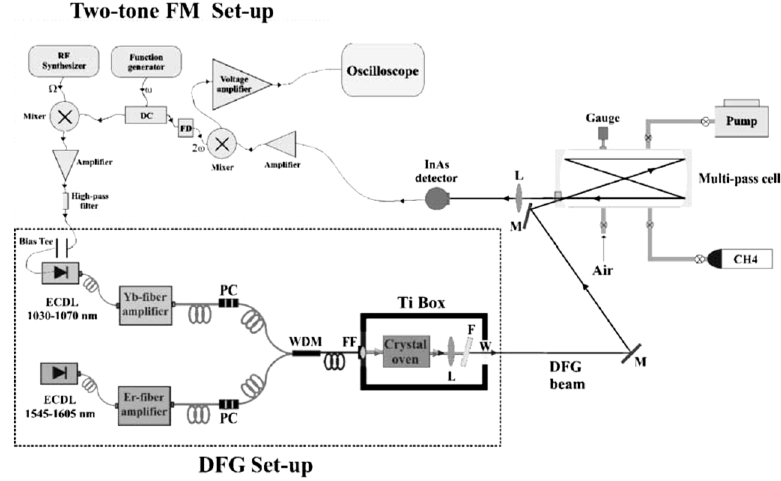
Figure 5. Schematic drawing of the experimental set-up of a portable spectrometer . Reproduced with permission from [122], Springer, 2006.